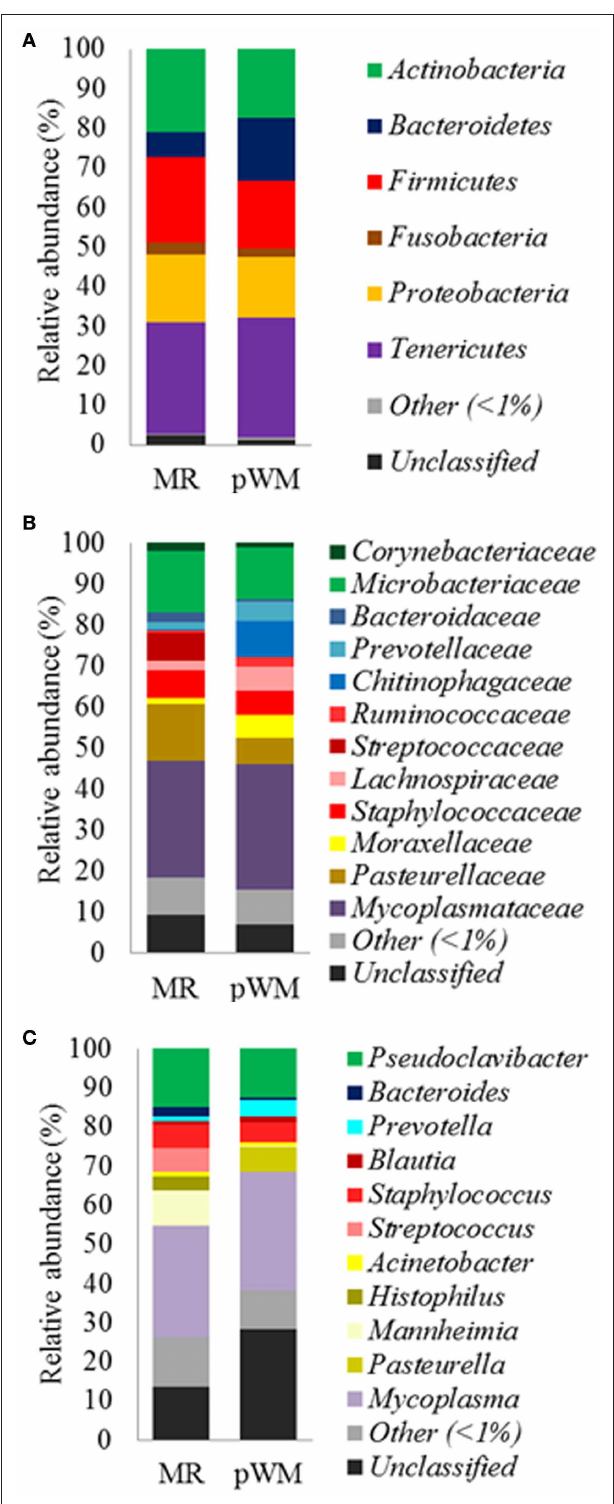
FIGURE 2 | Mean relative abundance (%) of bacterial phyla (A) ; family (B) , and genus (C) , in the nasal microbiota of dairy calves fed either milk replacer (MR) ( n = 8) or pasteurized waste milk (pWM) ( n =